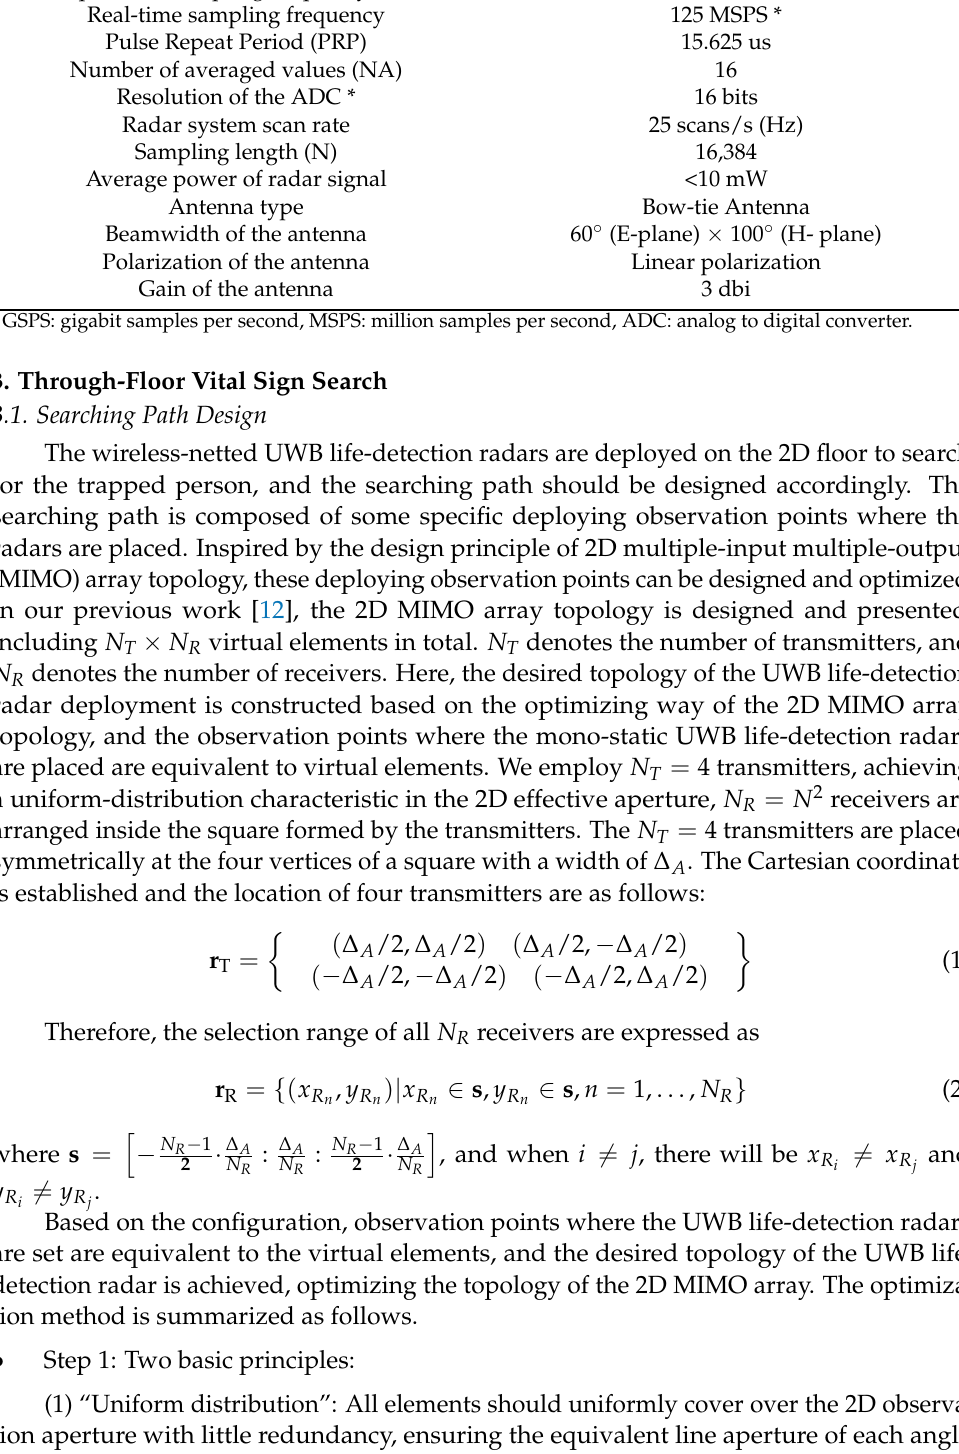
Table 1. Key parameters of the adopted wireless-netted UWB radar. Parameters Value Center frequency of UWB radar system